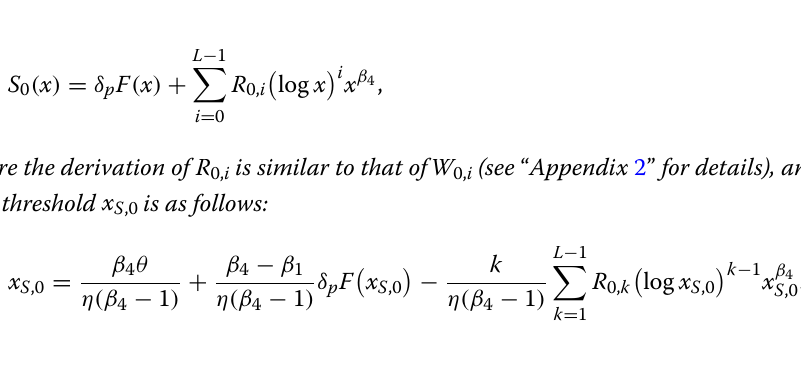
Fig. 4 Exit thresholds change with respect to the reduction factor δ p and arrival intensity (cid:31)